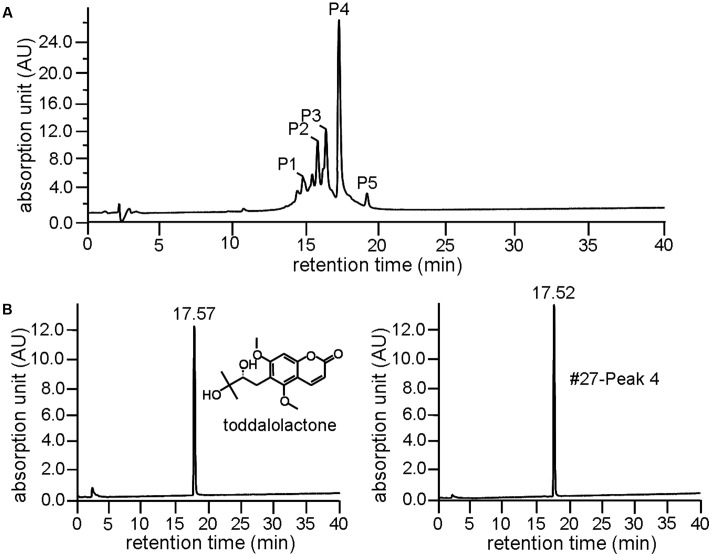
Identification of toddalolactone in the active fraction Z. nitidum var. tomentosum extract. (A) Analytical HPLC chromatogram of #27 with detection wavelength of 254 nm. (B) Chromatogram of toddalolactone standard (left) and Peak 4 of #27 of the extract (right) under the same chromatographic analysis condition. Inset: structure of toddalolactone.